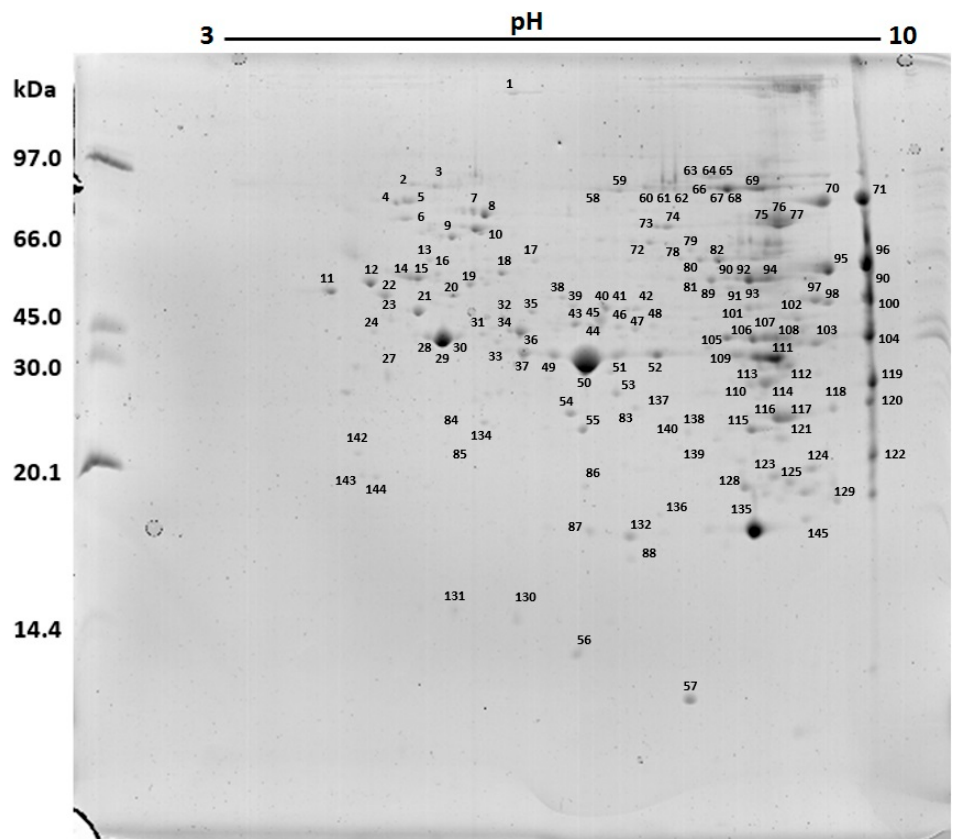
Figure 3. Spots corresponding to proteins identified in two-dimensional gel of Neoponera villosa venom.